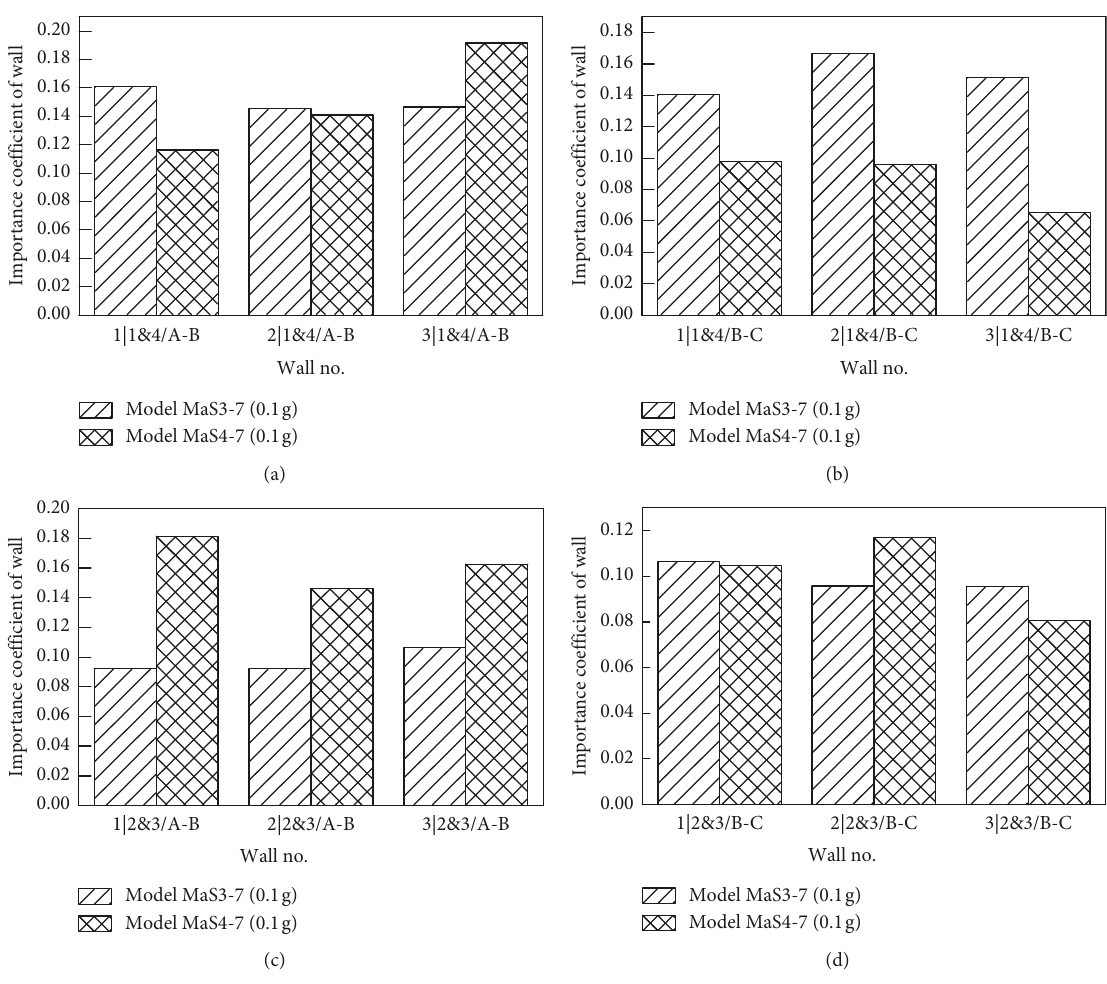
Figure 11: Floor wall importance coefficient of different layer structures. (a) Wall 1&4/A-B. (b) Wall 1&4/B-C. (c) Wall 2&3/A-B. (d) Wall